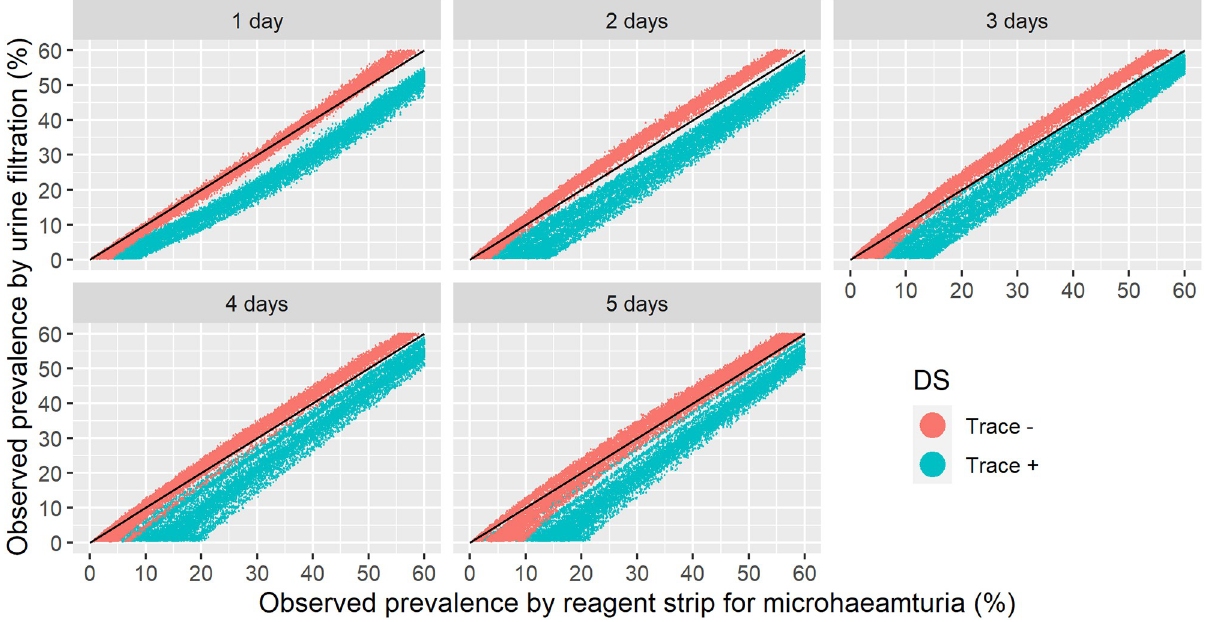
Fig 5. Simulated relation between observed prevalence of S. haematobium by urine filtration and by reagent strip based on one to five urine samples collected over consecutive days with traces considered either positive or negative. The black line indicates equivalence between urine filtration and reagent strip